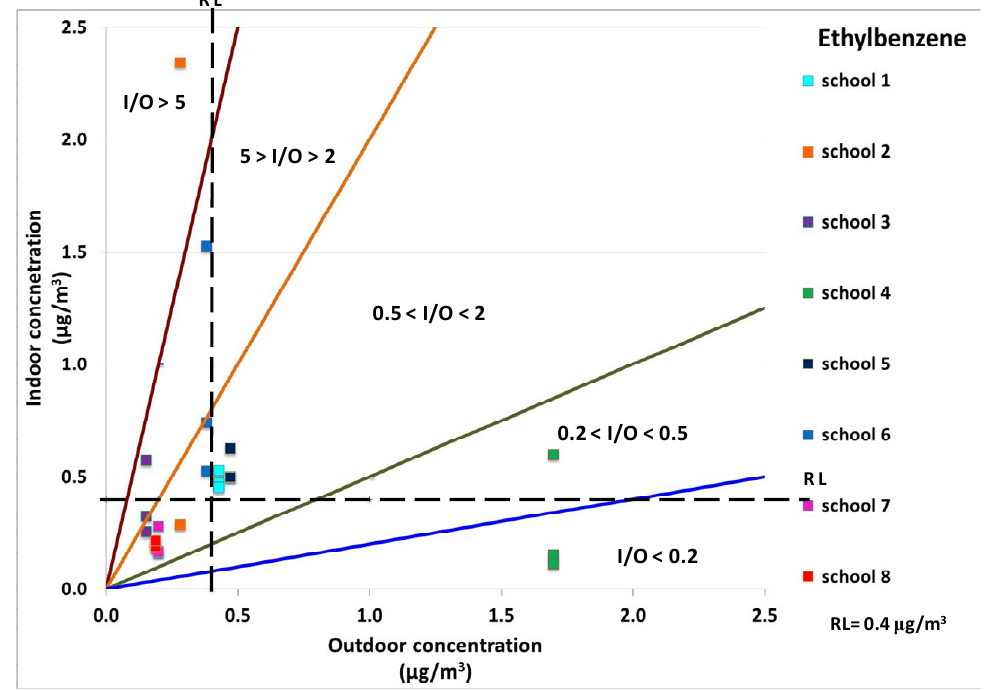
Figure 3. Ethylbenzene indoor concentrations against outdoor concentrations in all monitored sites. The reference level (RL) and five different I/O ranges were also displayed.